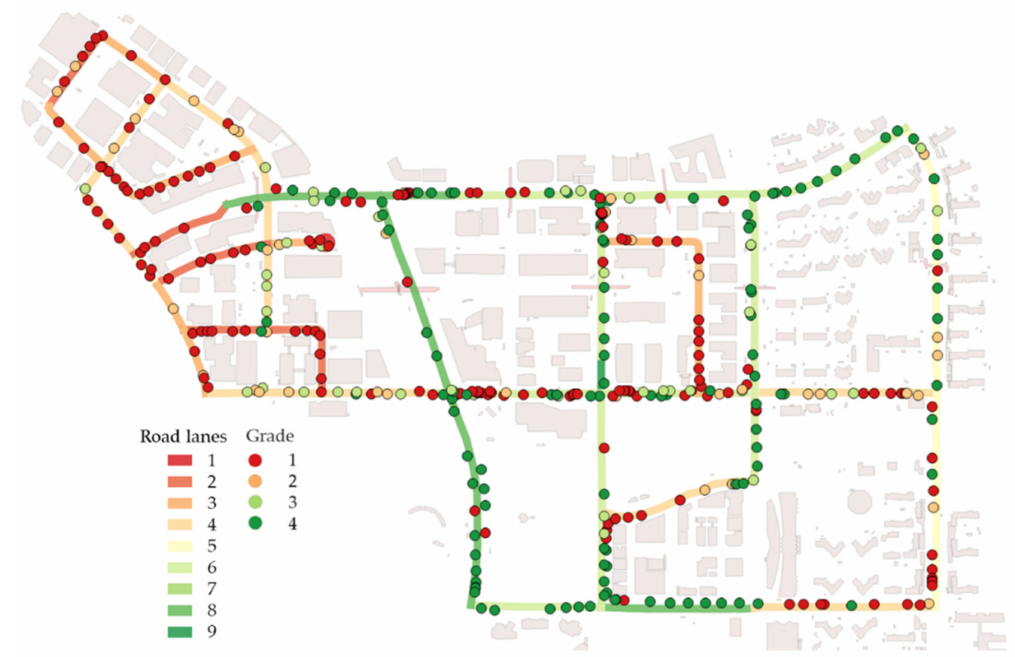
Figure 11. Comparison of grades at observation positions and the number of road